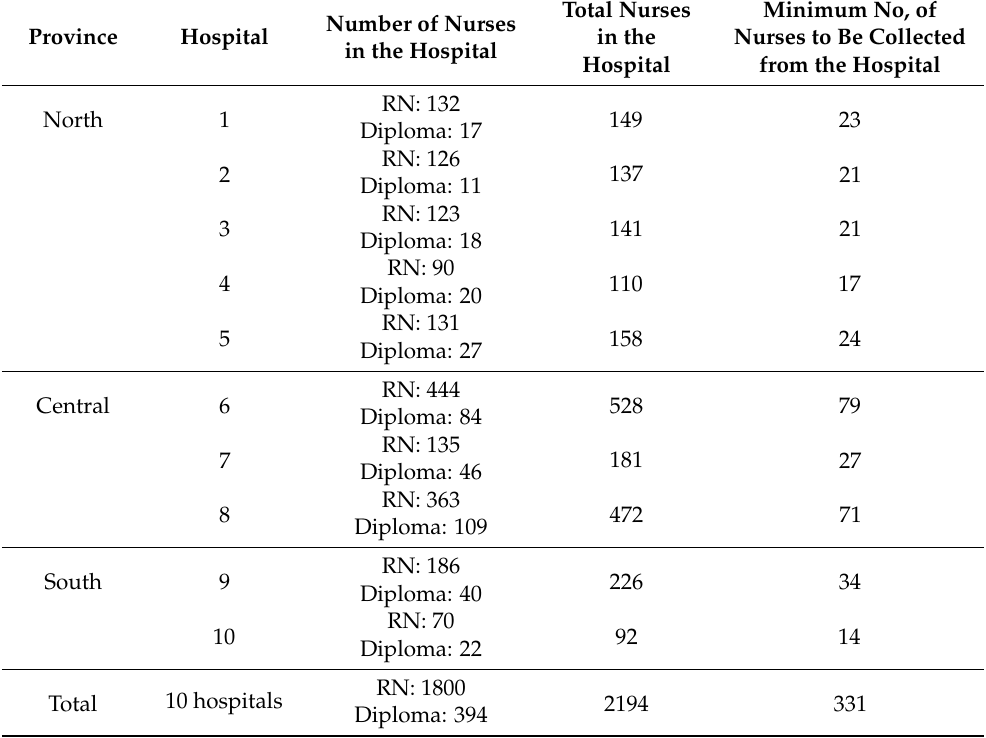
Table 1. Hospitals Fully Implementing an Electronic Health Records System in Jordan with the Number of Nurses Employed.